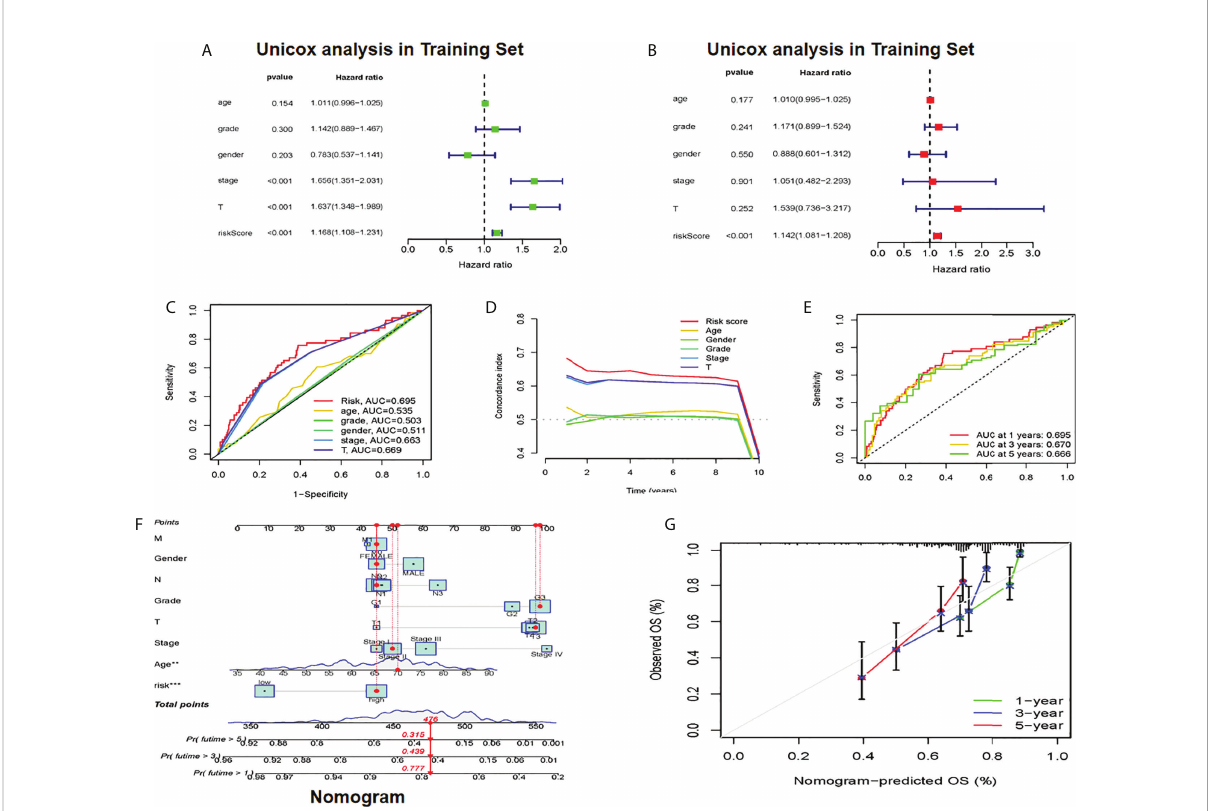
FIGURE 4 Establishment of cuproptosis-related clinicopathologic nomogram (A) Univariate Cox regression analysts of the signature CRLs and clinical parameters (B) Multivariate Cox regression analysis of the signature CRLs and clinical parameters (C) Development of a prognostic nomogram to predict 1-, 3- and 5-year OS in the HCC patients of the training set. (D) Clinical data c-index ROC curve (E) Characteristic CRLs to predict 1-, 3- and 5-OS of HCC patients in the traming set. (F) A prognostic nomogram was developed to predict the 1-, 3- and 5-year OS of HCC patients in the training set. (G) Prognostic nomogram predicted OS time, CRLs, cuproptosis-related lncRNAs; OS overall survival, HCC, hepatocellular carcinoma. *Means P<0.05, **Means P<0.01, ***means